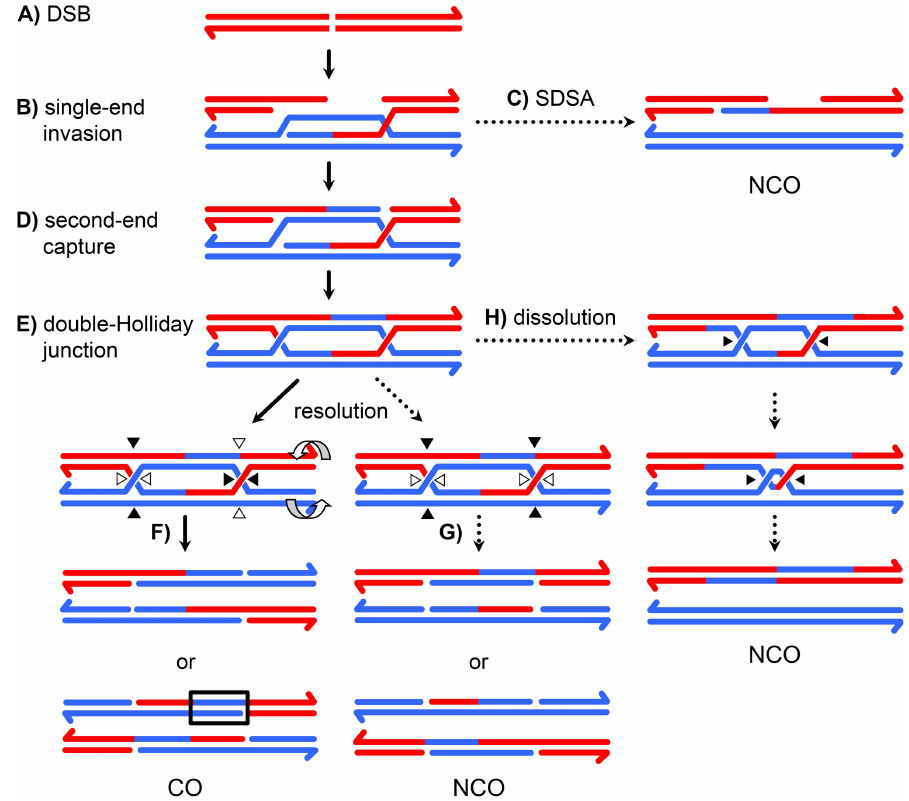
Figure 1. A current model of meiotic recombination. ( A ) A double-strand break (DSB) is processed to form 3 9 single strand overhangs. ( B ) One of the single strands invades the homologous chromosome, forming a single-end invasion intermediate. ( C ) After synthesis, this intermediate may be disassembled, allowing the newly synthesized DNA to anneal to the other resected end. This process, called synthesis dependent strand annealing (SDSA), generates NCOs only. This NCO is drawn with hDNA intact, but the nicks in the product would likely stimulate mismatch repair, possibly leading to a single tract of gene conversion to one side of the DSB. ( D ) In the absence of SDSA, the second end of the DSB may be captured by annealing to the displaced strand of the D-loop, priming synthesis. ( E ) This structure is ligated to form a double Holliday junction (dHJ). The HJs are cleaved in a process called resolution. ( F ) Cleaving different strands at each junction (left) results in a CO. One way of doing this (open arrowheads) results in products with a single hDNA tract; the other orientation (black arrowheads) gives products with MMR-independent gene conversion (outlined in black) adjacent to the tract of hDNA. ( G ) Cutting the same two strands at both junctions (right) results in a NCO. Both orientations give one product with a single tract of hDNA and one with hDNA adjacent to a gene conversion tract. Resolution, like SDSA, leaves nicks in the final products that are thought to direct mismatch repair. ( H ) dHJs may be dissolved by the combined activities of a helicase and topoisomerase, resulting in a NCO with trans hDNA and lacking